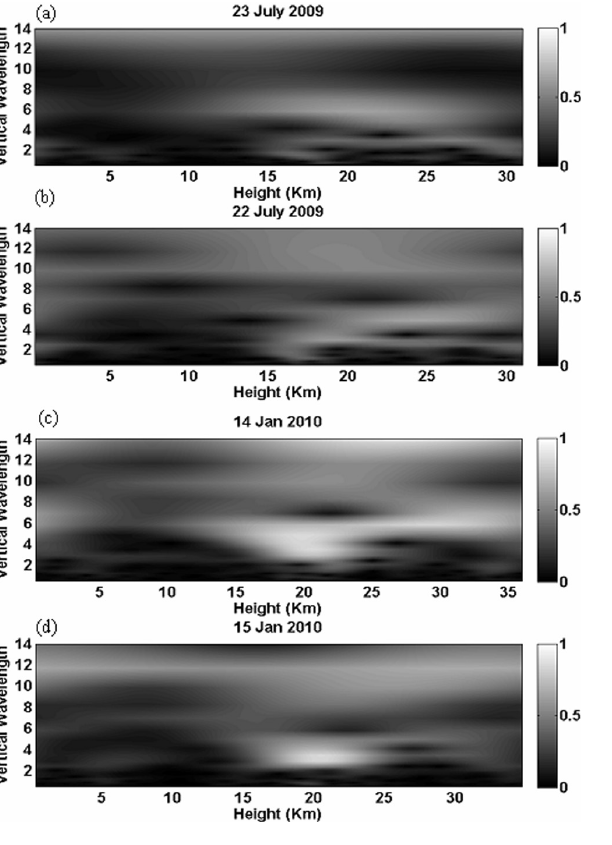
Fig. 6. Wavelet spectra of temperature fluctuations at 06:45IST on (a) control day (23 July) and (b) eclipse day (22 July) of partial solar eclipse of 2009. (c) and (d) same as (a) and (b) but for the annular solar eclipse of January 2010 at the maximum phase of the eclipse time at